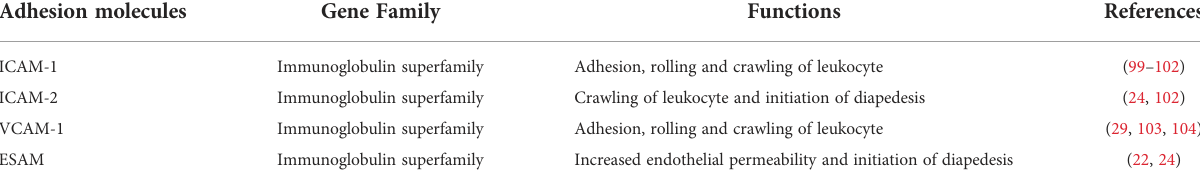
TABLE 2 The type and function of adhesion